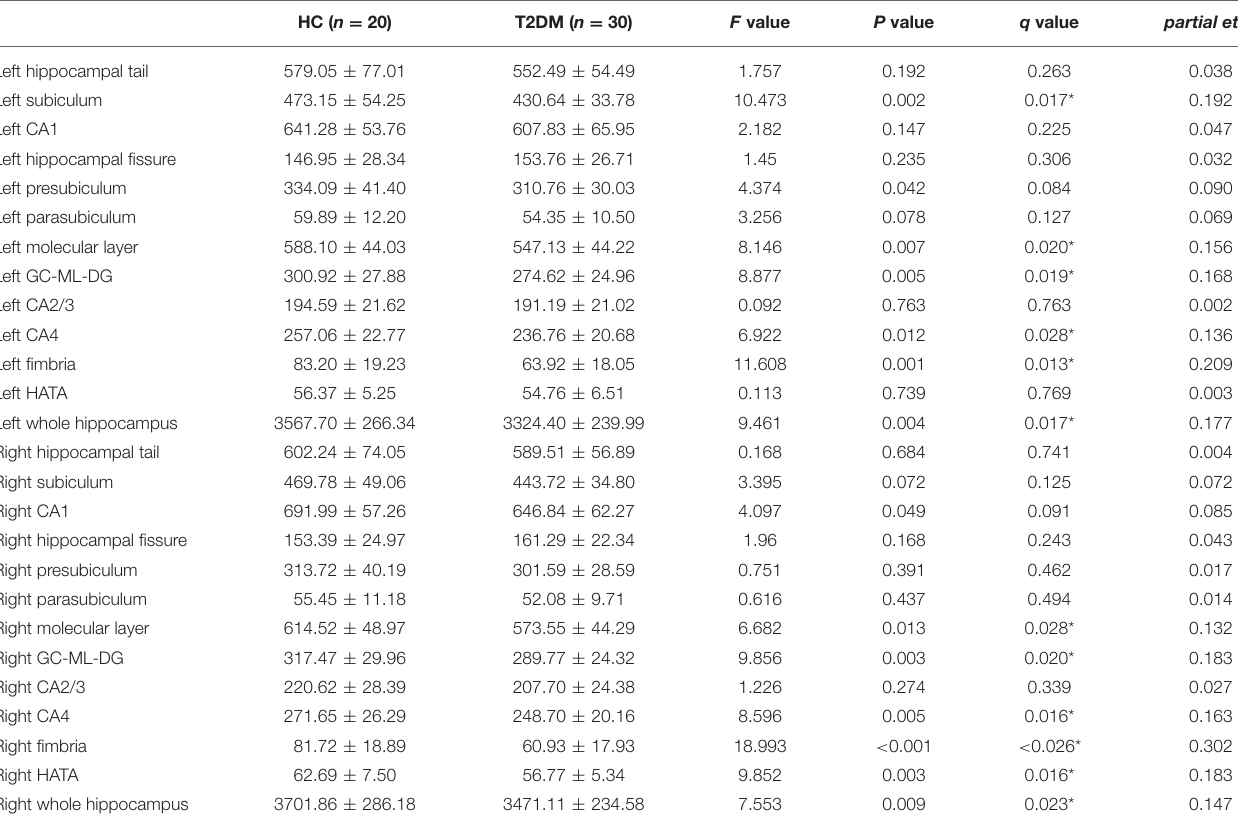
TABLE 3 | Group comparison of hippocampal subfields